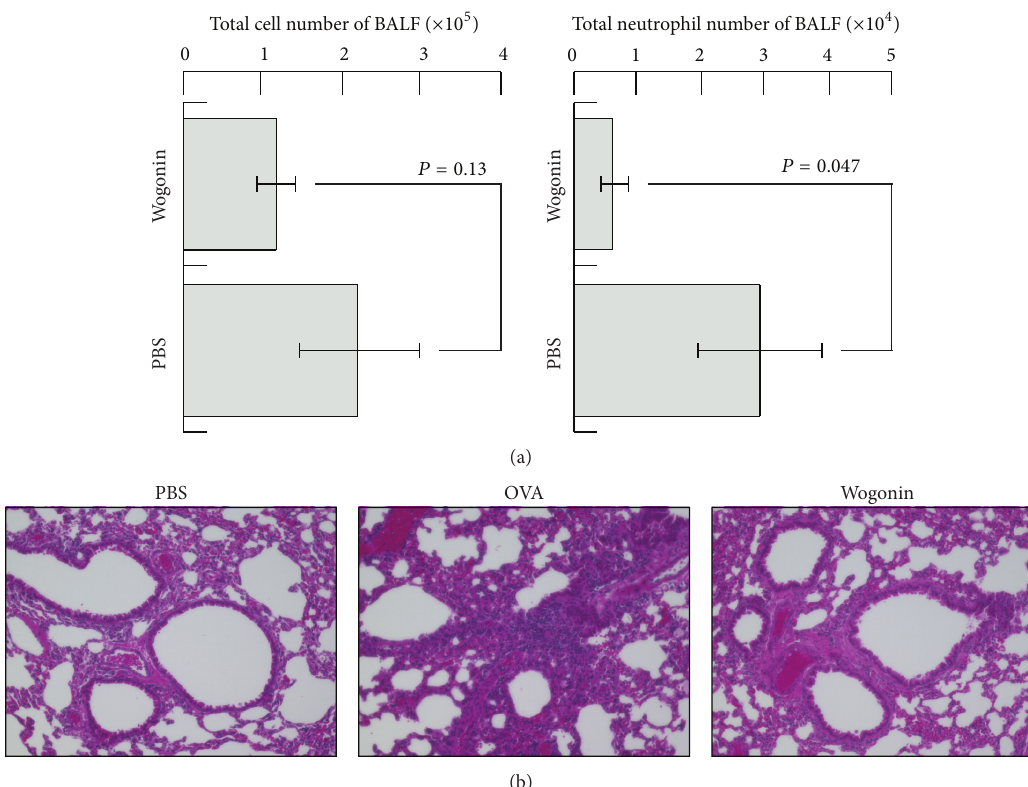
Figure2:Declineinthenumberofneutrophilsinfiltratingthebronchiandlungsinducedbywogonintreatment . DO11.10micewerenebulized with either OVA or PBS from days − 2 to 0. Some mice received wogonin (2mg/kg) or distilled water orally five times a week from days − 7 to 0. On day 1, the mouse BALF was collected in order to count the number of total cells ((a), left ) and neutrophils ((a), right ). The mouse lungs were excised and subjected to hematoxylin and eosin staining (b). Histological staining was performed on the lungs removed from the mice that received water and were nebulized with PBS (left panel), the mice that received water and were nebulized with OVA (center panel), and the mice that received wogonin and were nebulized with OVA (right panel). Original magnification: ×